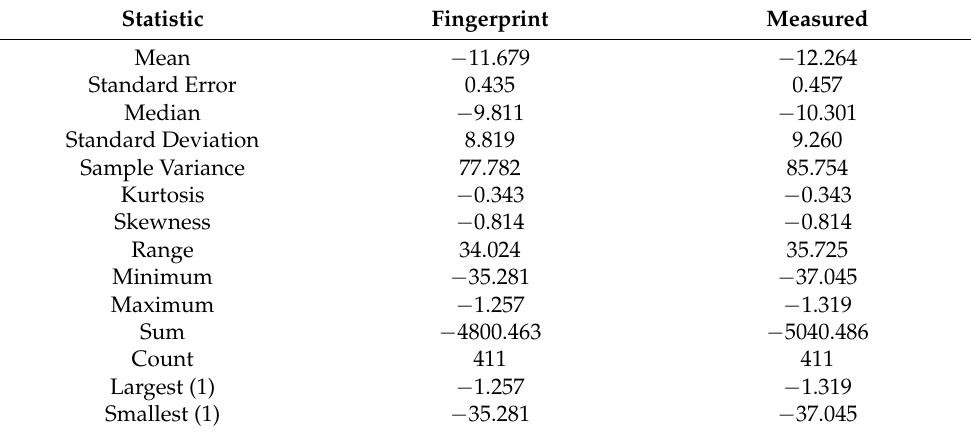
Table 7. Sub-region 3: Descriptive statistics comparison between fingerprint and measured FRA